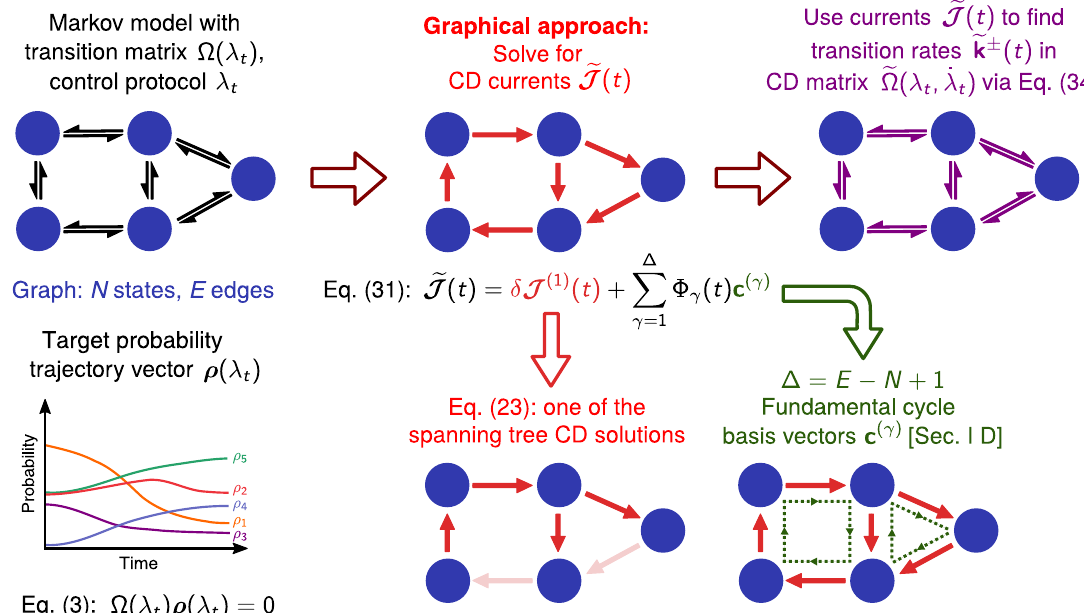
FIG. 2. Overview of the graphical approach for deriving CD solutions. We start with a Markov model defined by a transition matrix Ω ð λ λ N states, E edges, and a target trajectory ρ ð λ t Þ dependent on the control protocol t . Associated with this is a graph with t Þ consisting _ λ ˜ Ω ρ ð λ of instantaneous stationary states of Ω ð λ t Þ . The eventual goal is to find the CD transition matrix ð λ t ; t Þ , where t Þ is the solution to ˜ J the associated master equation, Eq. (4). To facilitate this, we must first find the CD currents ð t Þ , the main goal of the graphical ˜ J approach. The most general form of the solution for ð t Þ is given by Eq. (31), and consists of two components: (i) a spanning tree CD solution δ J ð 1 Þ ð t Þ , given by Eq. (23) and derived via the procedure outlined in Sec. II B, and (ii) a linear combination of the fundamental basis cycle vectors c ð γ Þ , γ ¼ 1 ; … ; Δ , where Δ ¼ E − N þ 1 , as described in Sec. II D. The coefficient functions Φ γ ð t Þ are arbitrary. ˜ ˜ J _ λ ˜ Ω k (cid:2) ð t Þ that determine Once the CD currents ð t Þ are known, we can use Eq. (34) to solve for the CD transition rates ð λ t ; t Þ